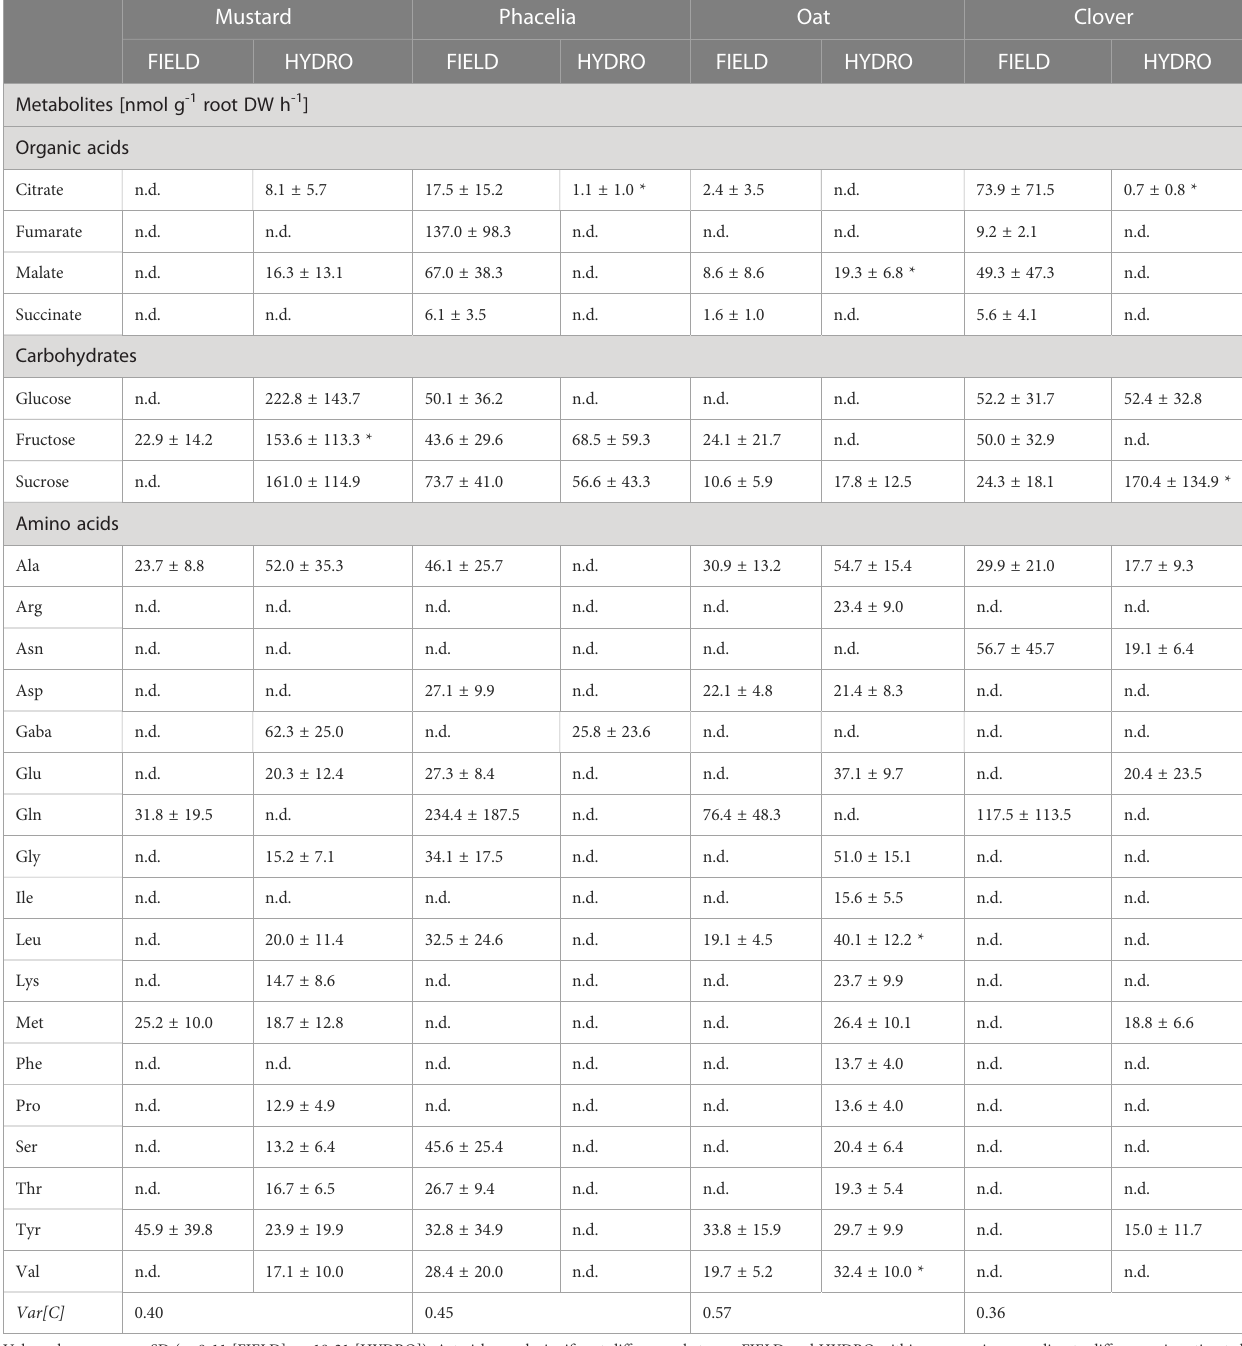
TABLE 1 Exudation rates of primary metabolites by cover crop roots in the fi eld (FIELD) and in hydroponic culture